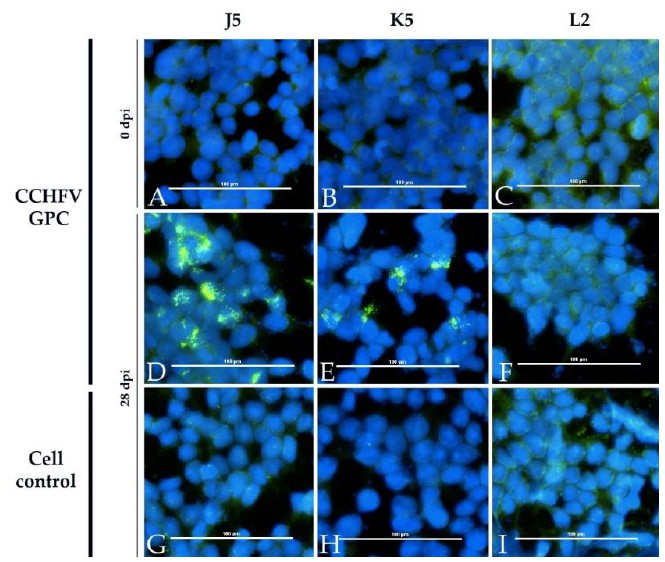
Figure 8. CCHFV immunofluorescence assay with DUGV cattle antisera: Cells expressing CCHFV GPC ( A – F ) and non-transfected controls ( G – I ) are depicted. Calf J5 ( A + D + G ) and K5 ( B + E + H ) show a specific staining of CCHFV GPC-transfected cells, whereas the serum of the control calf L2 ( C + F + I ) did not test positive. Sera prior to infection ( A – C ) did not lead to a positive signal on cells transfected with CCHFV GPC.